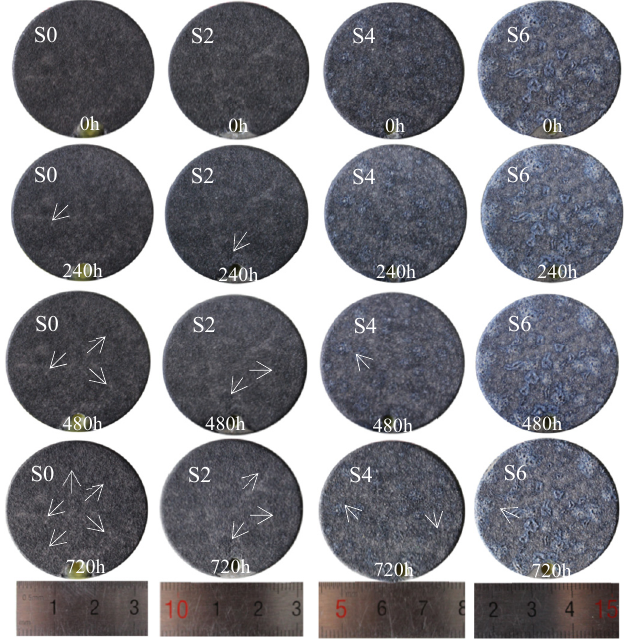
Figure 11. MAO coating after different times by salt spray corrosion.